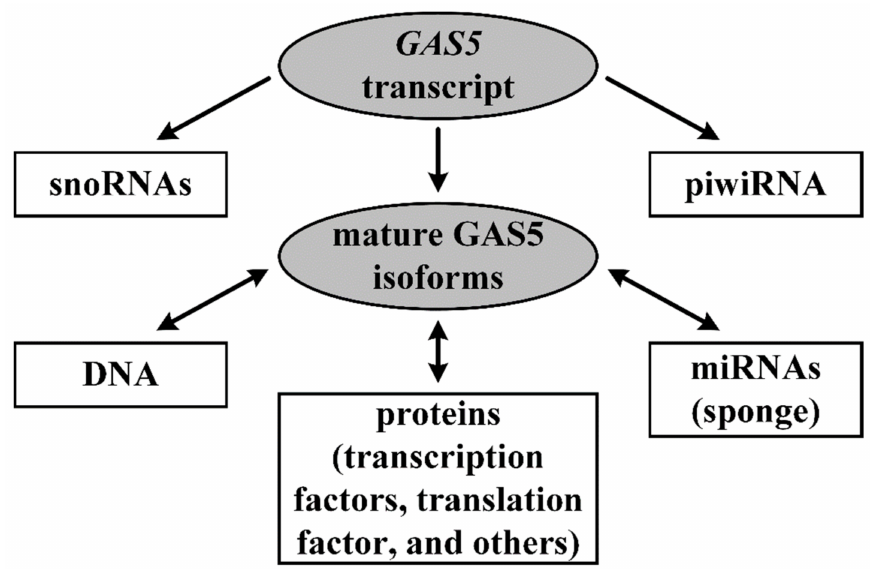
Figure 1. Functions of the GAS5 gene in a cell. Straight arrows—biogenesis; double-headed arrows—